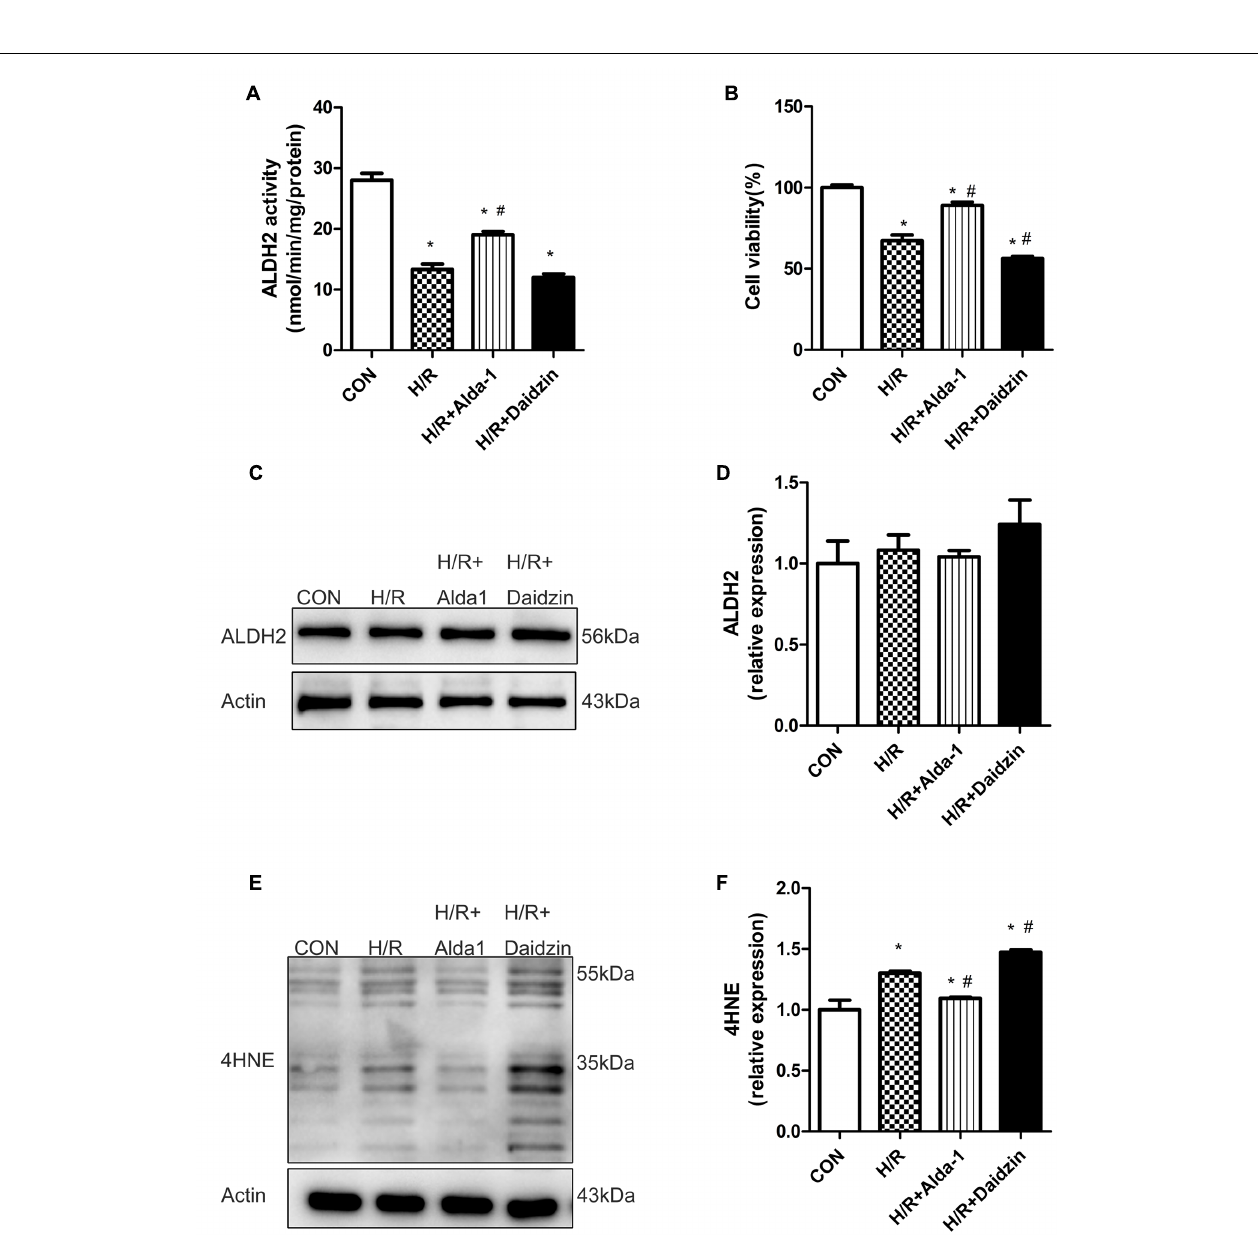
FIGURE 4 | ALDH2 activity and expression, cell viability and 4HNE accumulation in H/R-treated H9C2 cells. (A) ALDH2 enzymatic activity ( P < 0.0001, One-way ANOVA). (B) Cell viability ( P < 0.0001, One-way ANOVA). (C) Representative gel blots of protein expression of ALDH2 and Actin (loading control). (D) Quantification analysis of ALDH2 expression ( P = 0.5003, One-way ANOVA). (E) Representative gel blots of expression of 4HNE. (F) Quantification analysis of 4HNE expression ( P = 0.0002, One-way ANOVA). Data are mean ± SD from 3 independent experiments. ∗ P < 0.05 vs. sham; # P < 0.05 vs. H/R.